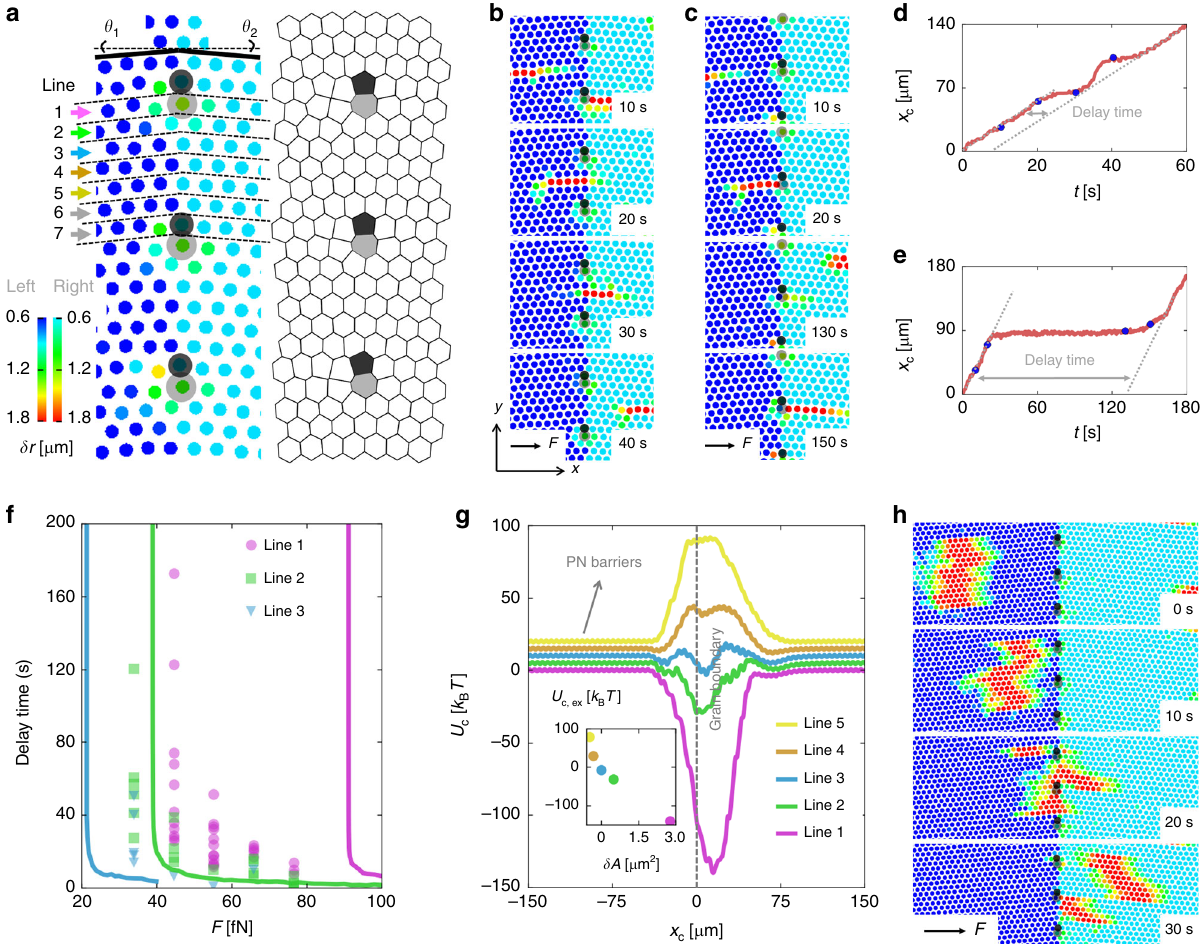
Fig. 2 Slowing down of interstitials by small-angle GBs. a Left: color-coded experimental images showing particle positions near a GB ( θ 1 = θ 2 = 4.72°). To highlight the position of the GB, slightly different color maps are used at the two sides of the GB. Arrows indicate the seven different lattice lines. Right: Voronoi tessellation of the left image, pentagons are fi lled with black, heptagons are fi lled with gray, hexagons are not fi lled. b , c Snapshots showing a w = 1 interstitial going across the GB via line 4 and line 1, respectively at F = 45 fN. The particle color code and the highlight of 5 – 7 pairs are as in ( a ). d , e The center-of-mass displacements x c of the interstitials in ( b ) and ( c ), respectively, as a function of time t . The dots correspond to the snapshots in ( b ) and ( c ), respectively. The delay time is de fi ned as the horizontal distance between the trajectories before and after the delay at GB. f The measured delay time as a function of F for w = 1 interstitials following different lattice lines across the GB. For line 1, the delay time diverges around F = 45 fN. For the other lines avoiding the 5 – 7 pairs, the delay time, as well as the critical force, is smaller. Lines are results from corresponding (same color) T = 0 simulations of the experimental data points. g The potential energy U c of an interstitial with w = 1 versus its center-of-mass position along lines 1 – 5. The GB is at x = 0. The curves are shifted from one another by 5 k B T for clearance. Due to the lattice distortion at the GB, the potential energy deviates signi fi cantly from the regular-lattice PN potential, over an interval from x ~ − 20 µ m to x ~ 40 µ m, consistent with the total length of the interstitial. (Inset) The extreme energy U δ A = A − A F = 45 fN, a w = 14 interstitial is being c,ex at the valley or peak as a function of relative Voronoi area GB 0 of lattice points at the GB. h At spliced when traveling through this GB. The particle color code and the highlight of 5 – 7 pairs are as in ( a